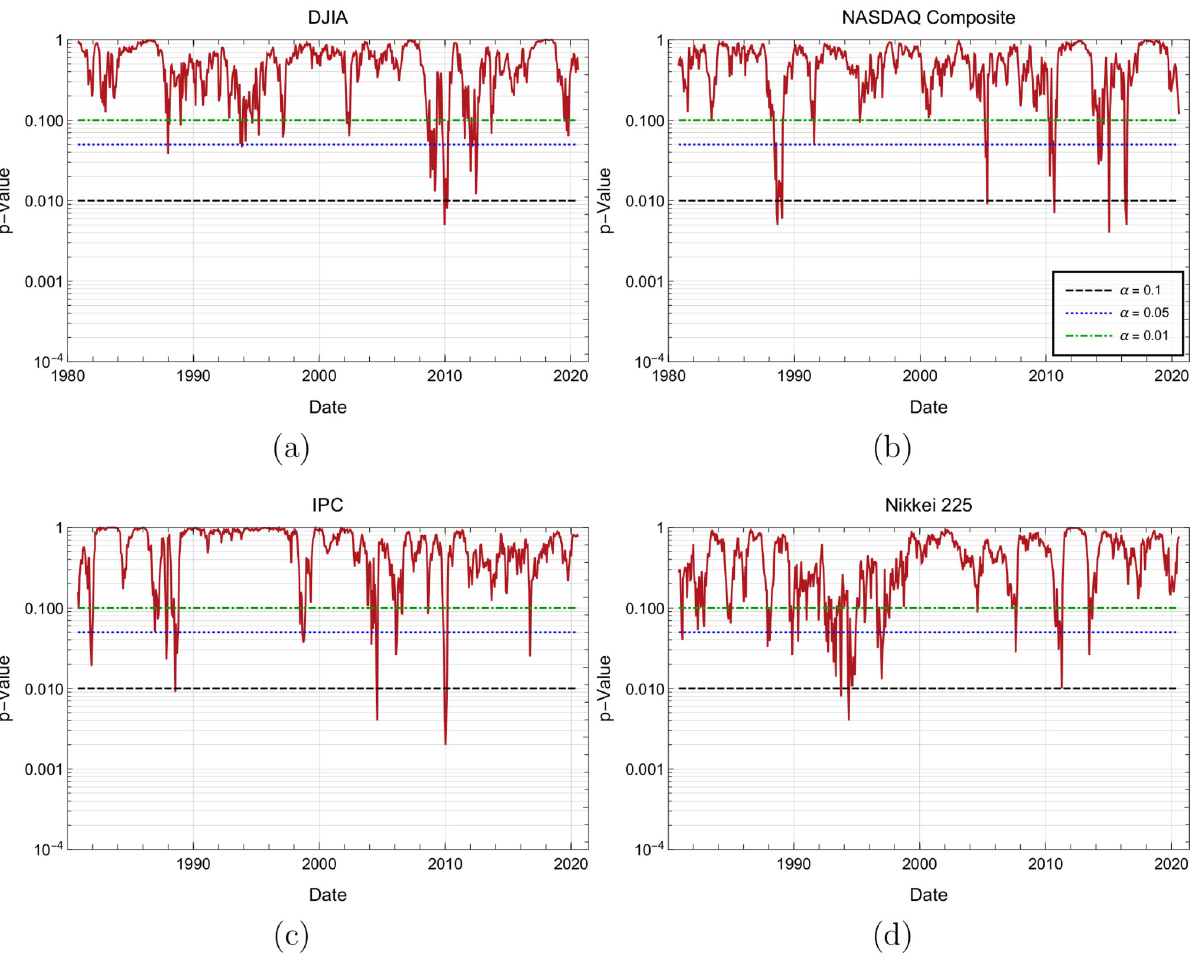
Fig 9. p -values of the parametric family Anderson-Darling statistic for the studied markets. 9(a) is DJIA, 9(b) is Nasdaq, 9(c) is IPC and 9(d) is